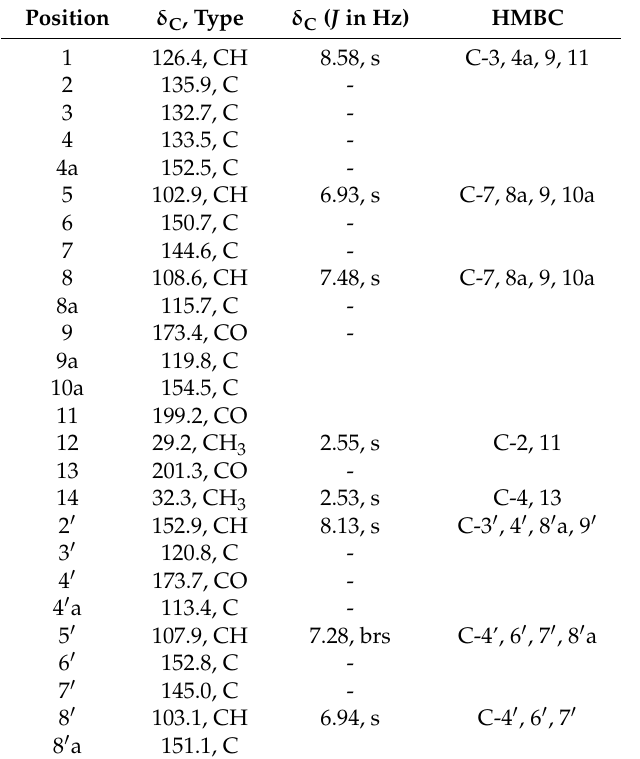
Table 2. The 1 H- and 13 C-NMR (DMSO- d 6 , 500 and 125 MHz) and HMBC assignment for 2